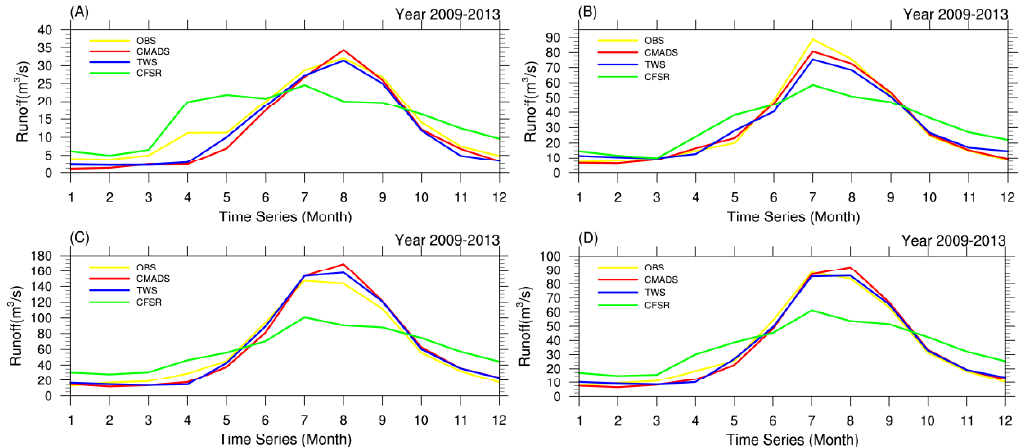
Figure 12. Comparison between five-year average monthly runo ff (2009–2013) simulated results from three different modes (TWS + SWAT, CFSR + SWAT, and CMADS + SWAT) and observed values at ( A ) Qilian Mountain Sub-basin, ( B ) ZhaMashenke Sub-basin, ( C ) Ying Luoxia Sub-basin, and for the ( D ) average basin value.